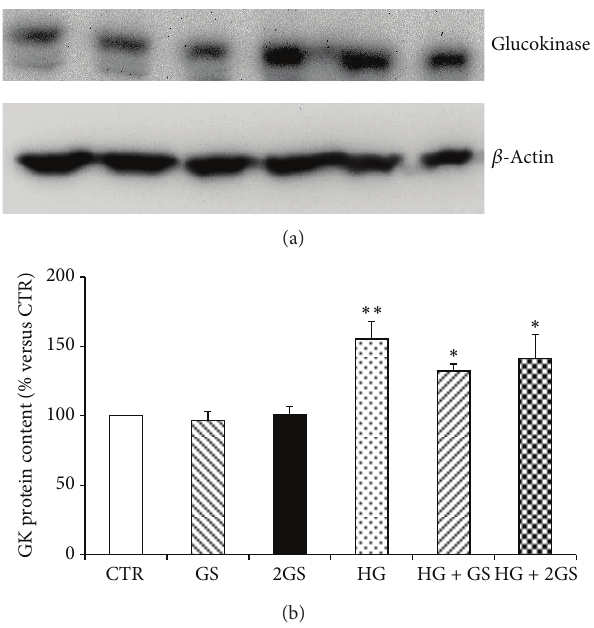
Figure 8: GS abrogates insulin-induced phosphorylation of IRS- 1(Tyr-895) at both low and high glucose concentration. After 5- day treatment in the presence of standard medium (CTR) or high glucose concentration (25 mmol/L) (HG) in presence of different concentrations of glycated serum (400 [GS] and 800 nmol/L [2GS]), GLUTag cells were incubated for 2 hours in serum-free medium and, then, exposed in the presence (dark bars) or absence (white bars)of100 nmol/Linsulinfor5 min.(a)Representativewesternblot analysis. (b) Quantification of densitometries of western blot bands. Data were expressed as mean ± SE of fold induction relative to 𝛽 - actin ( 𝑛 = 4 ). ∗ 𝑃 < 0.05 and ∗∗ 𝑃 < 0.01 versus absence of insulin; n.s.: